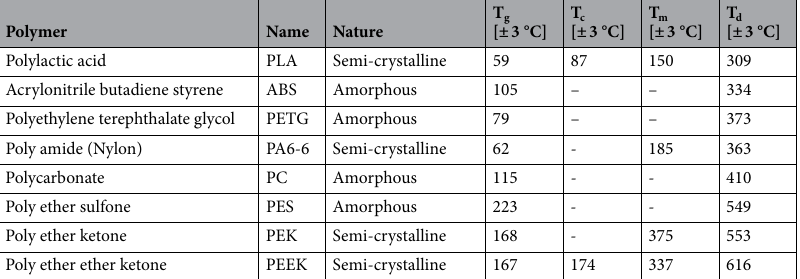
Table 1. Glass transition temperature T g , onset crystallization temperature T c , melting temperature T m and decomposition temperature T d of various amorphous and semi-crystalline thermoplastic